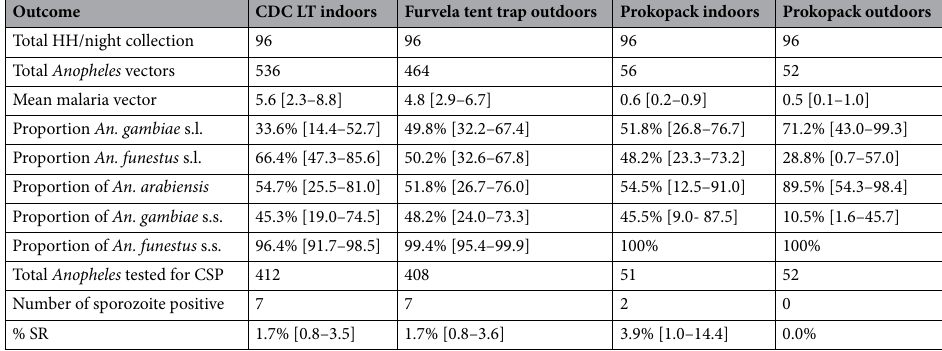
Table 4. Indoor and outdoor Anopheles feeding and resting behaviours and species composition. CDC Centers for Disease Control and Prevention, CSP circumsporozoite protein, HH household, LT light trap, SR sporozoite rate.